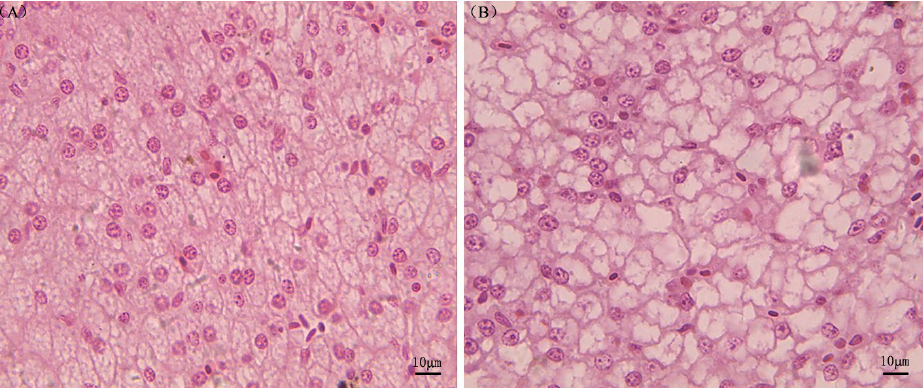
Figure 1. Photomicrographs of histological sections of A. schrenckii livers. Note: Panel ( A ) displays hepatocytes with proper nuclei, while panel ( B ) shows fatty infiltration of hepatocytes. The sections were stained with hematoxylin and eosin.